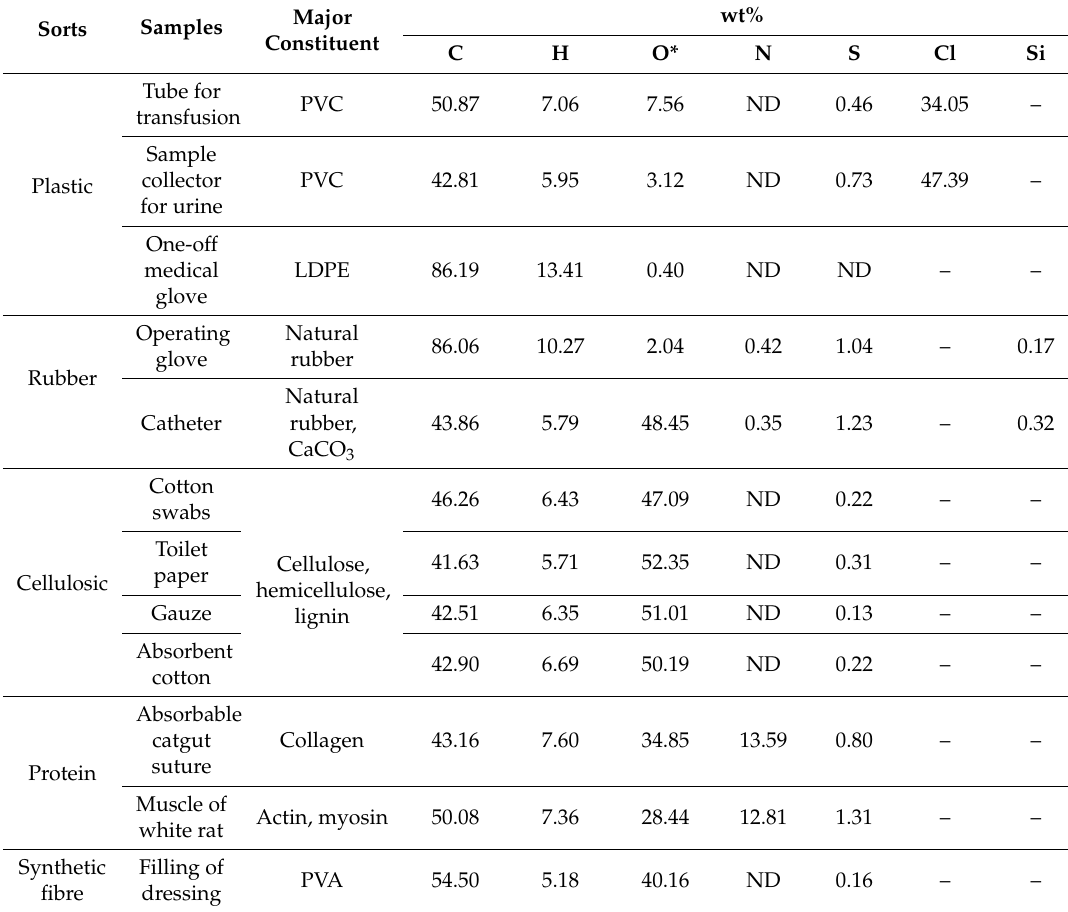
Table A1. Ultimate analysis of typical medical waste composition